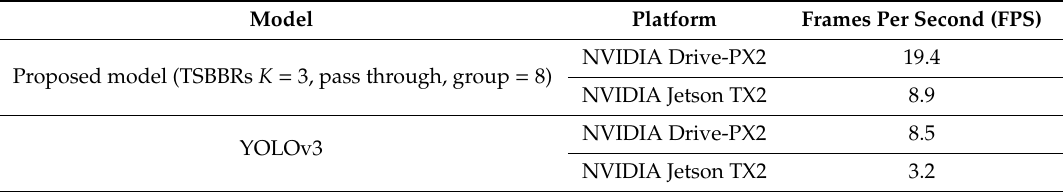
Table 14. Performance of the proposed design on two portable platforms. Model Platform Frames Per Second (FPS) Proposed model (TSBBRs K = 3, pass through, group = 8)